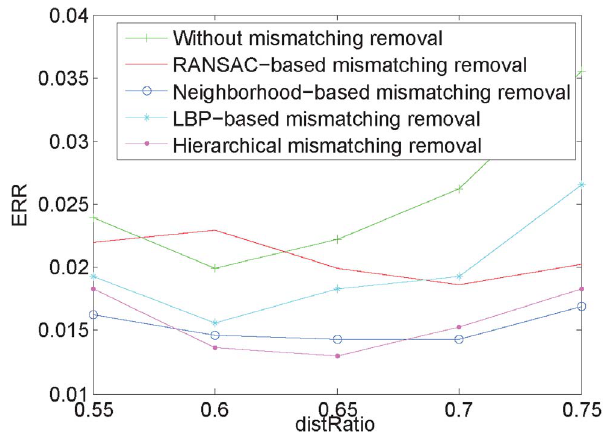
Figure 14. Results from different methods for mismatching